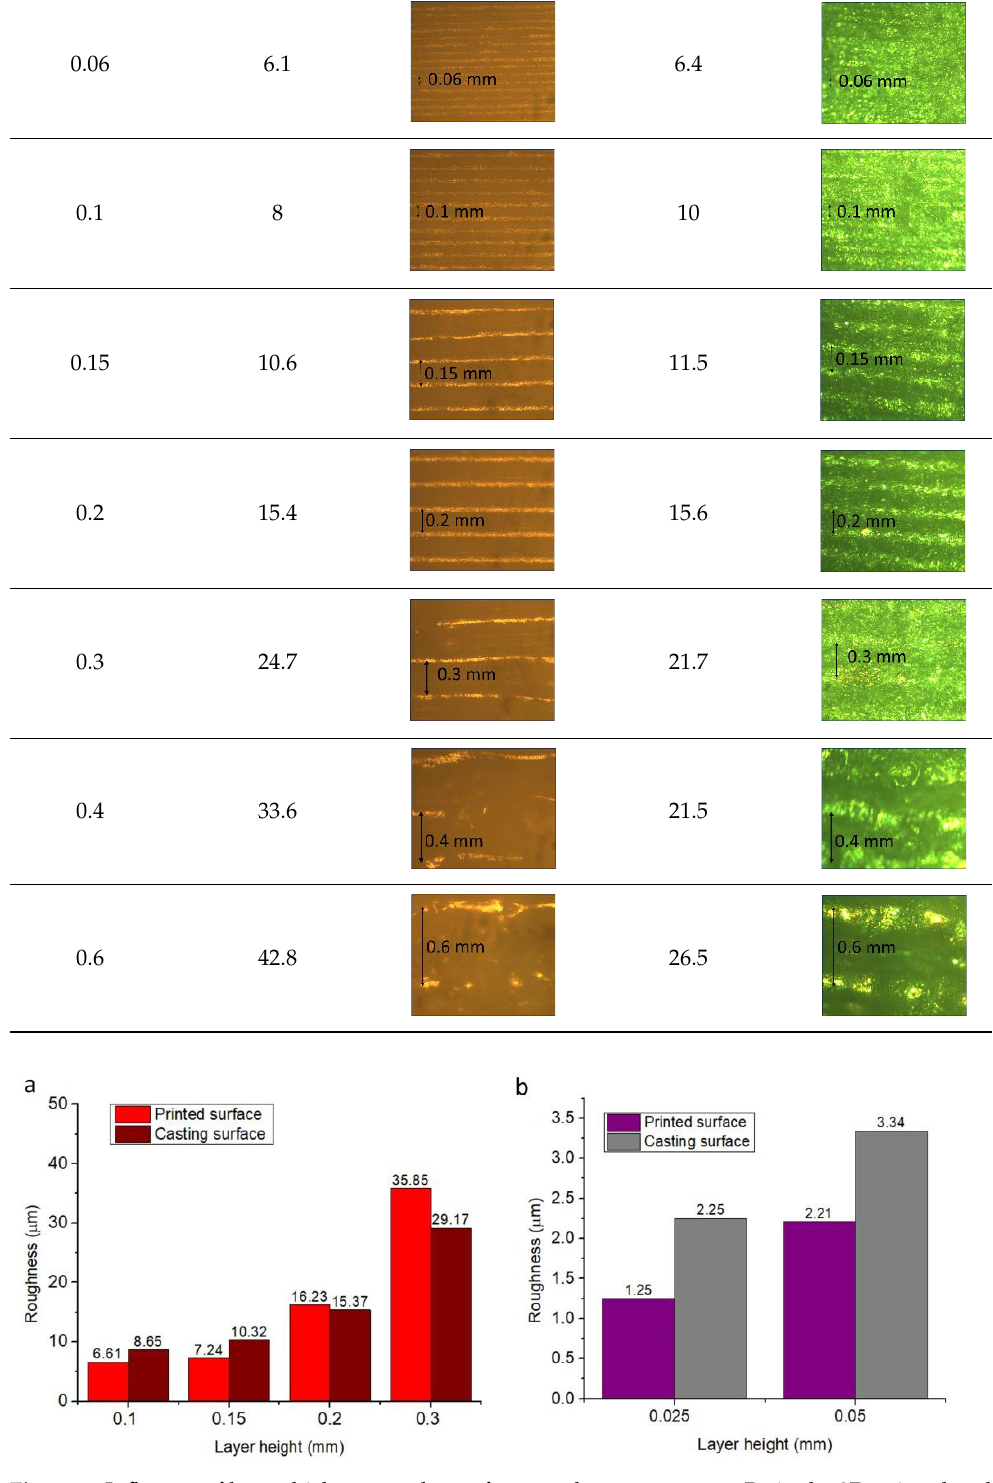
Table 1. The roughness and optical microscopic images (OMI) of the PLA–printed surface and casted surface vary with infill density and layer height.